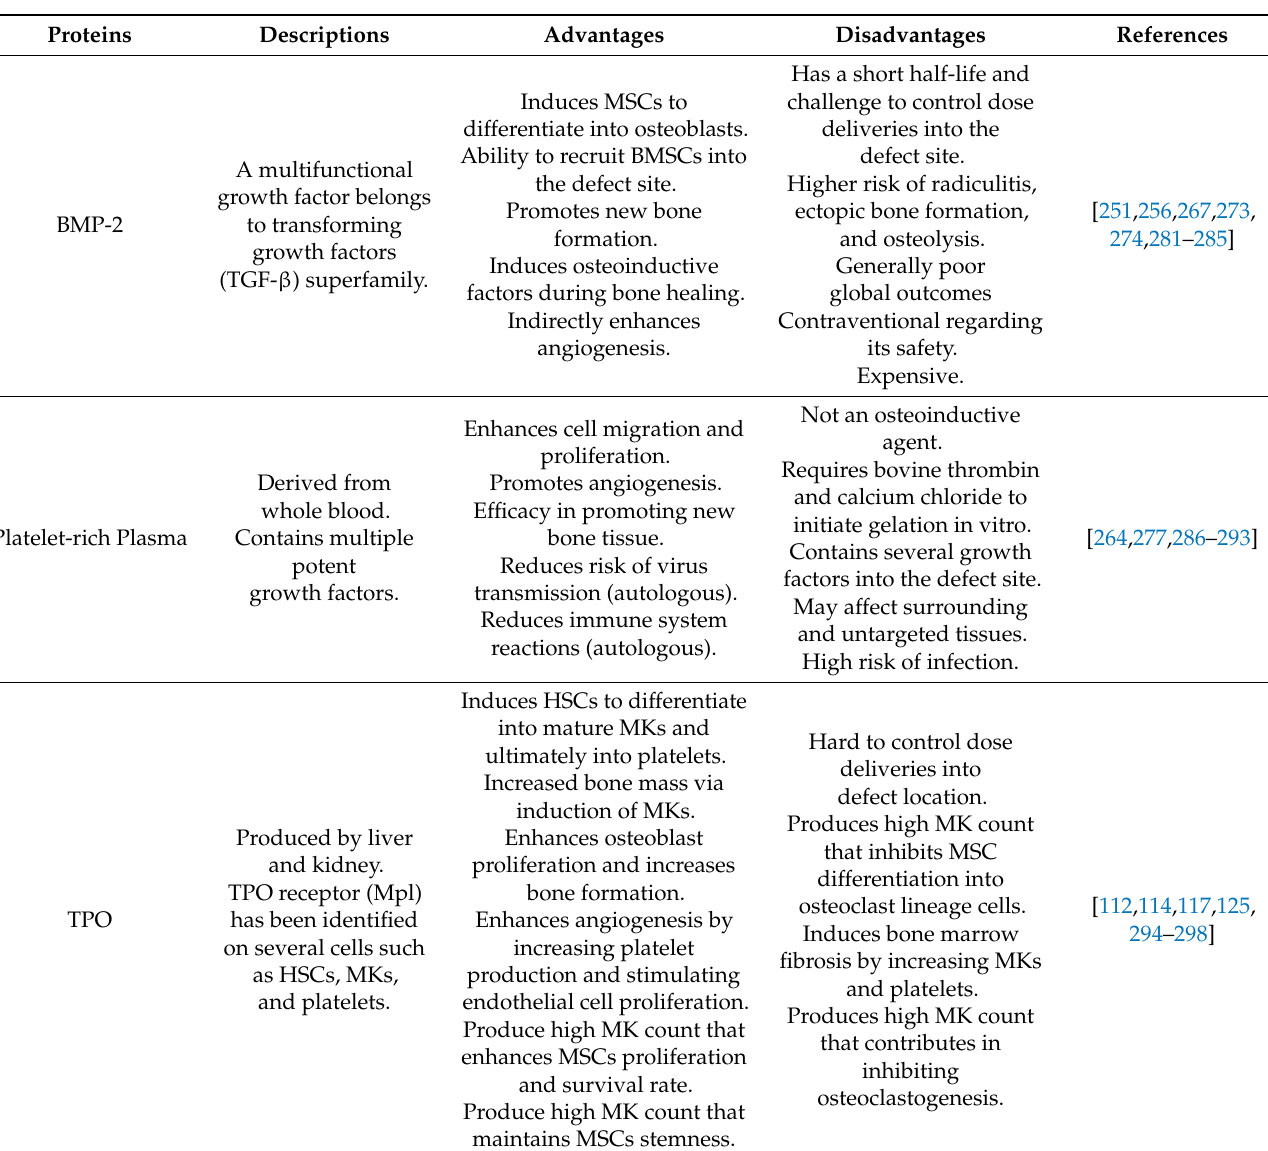
Table 2. Advantages and disadvantages of protein-based